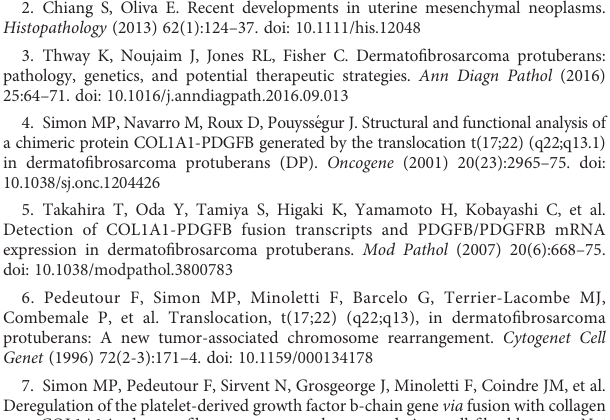
SUPPLEMENTARY FIGURE 1 Pelvic MRI showed that an oval mass protruding from the cervix to the vagina and compressed on the anterior bladder with a slightly higher signal (A) . The mass was signi fi cantly enhanced, remarkably higher than that of the uterus post-enhancement (B)